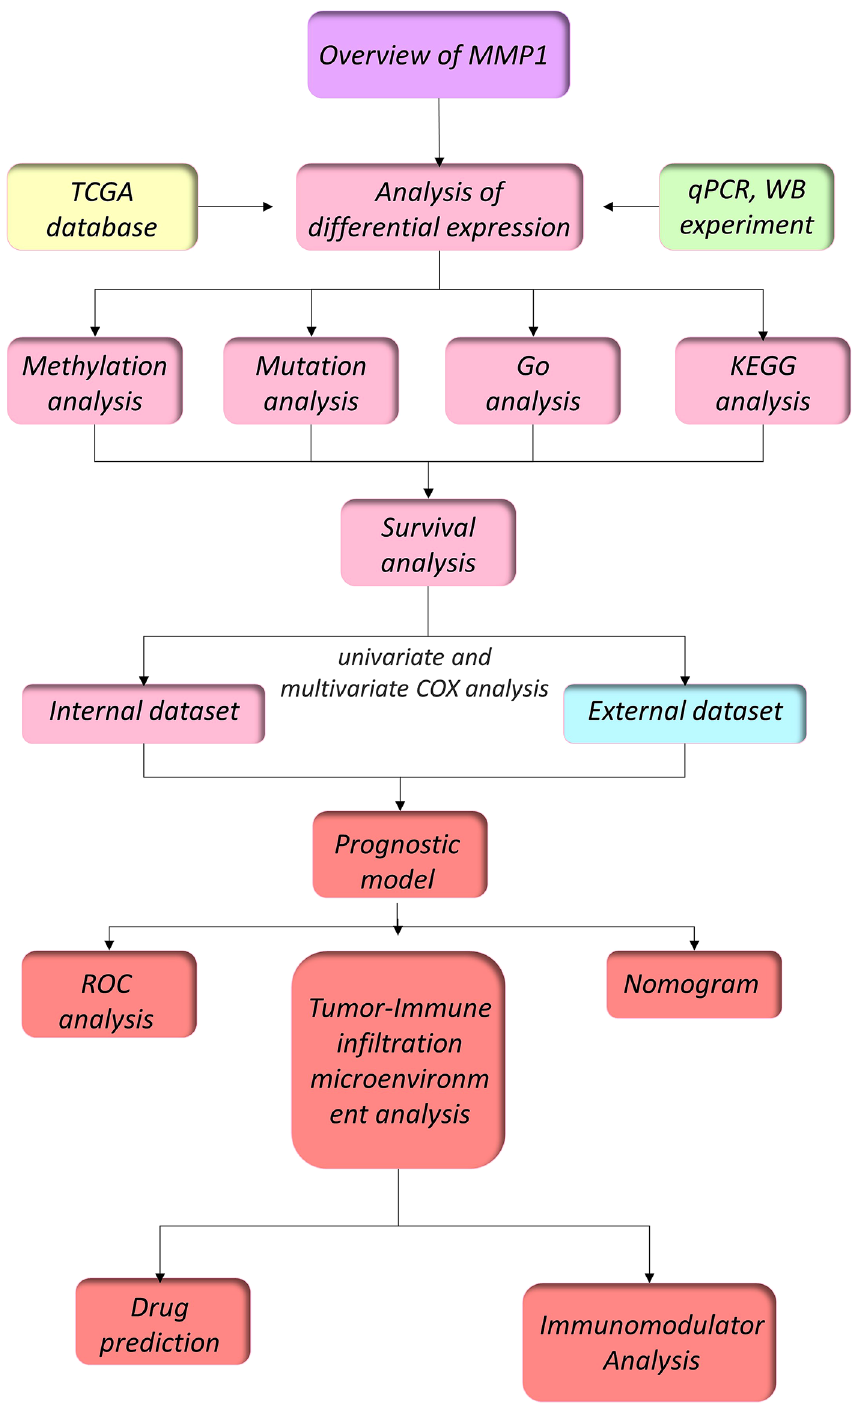
Figure 1. Study design flow chart. TCGA, the cancer genome atlas; qPCR, quantitative Polymerase Chain Reaction; WB, western blot; ROC, receiver operating characteristic